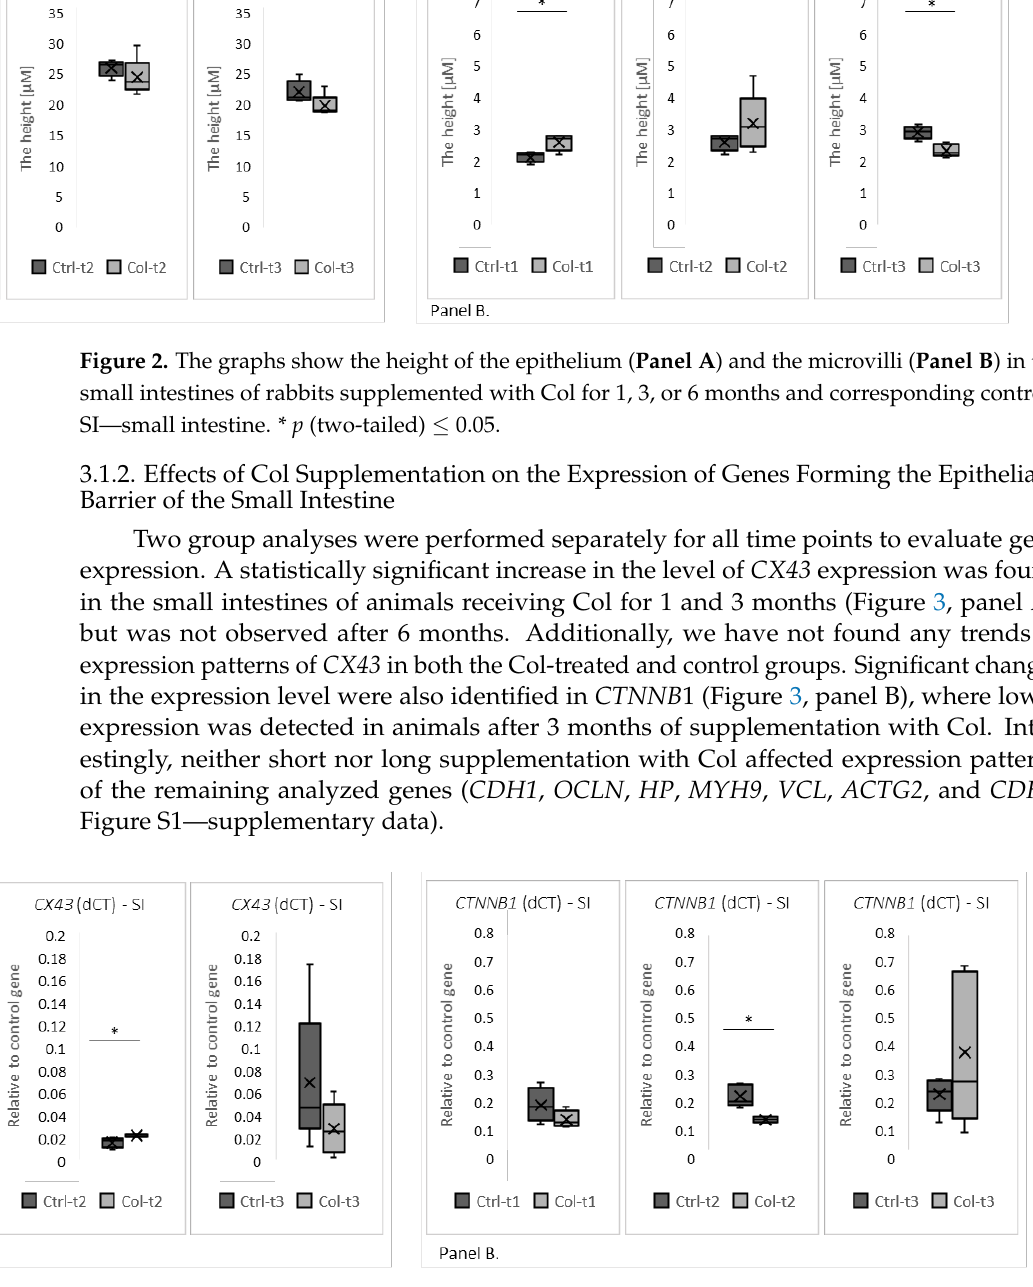
Figure 3. The charts show the deltaCt (dCt), the fold change of gene expression (relative to the housekeeping gene GAPDH) in the small intestine. The ( Panel A ) shows CX43 and the ( Panel B ) shows CTNNB 1 expression at all three time points of Col supplementation. SI—small intestine. * p (two-tailed) ≤ 0.05.